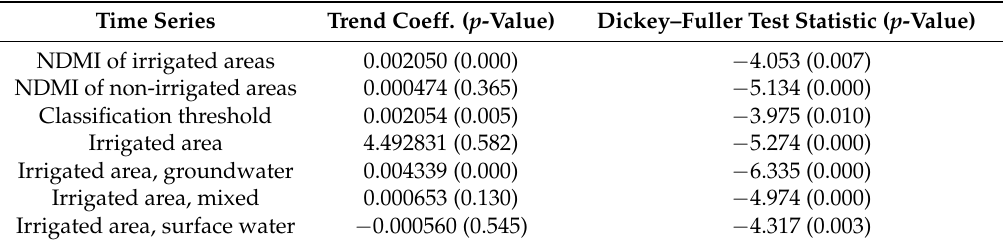
Table A3. Regression results, all time series.